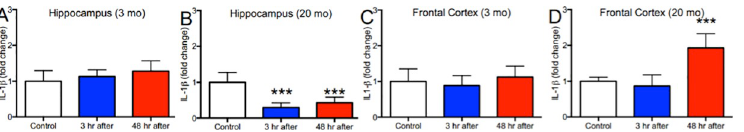
Fig 2. Isoflurane produces age- and region-dependent changes in IL-1 β gene expression. 3 and 20-month-old mice were anesthetized with 1.2% isoflurane in 30% oxygen for 4 h and sacrificed 3 h or 48 h later and IL-1 β measured in the hippocampus and frontal cortex by RT-PCR. Isoflurane had no effect in either region in young mice (panels A & C). In contrast, it produced a marked and sustained decrease in IL-1 β mRNA in the hippocampus and an increase in the cortex 2 d later in aged mice (panels B & C) demonstrating age and region specific effects of treatment with isoflurane. Data expressed as mean ± SD for N = 6 animals per treatment condition. ��� p < 0.001 relative to age-matched controls by 1-way ANOVA with Dunnett’s test for multiple comparisons.